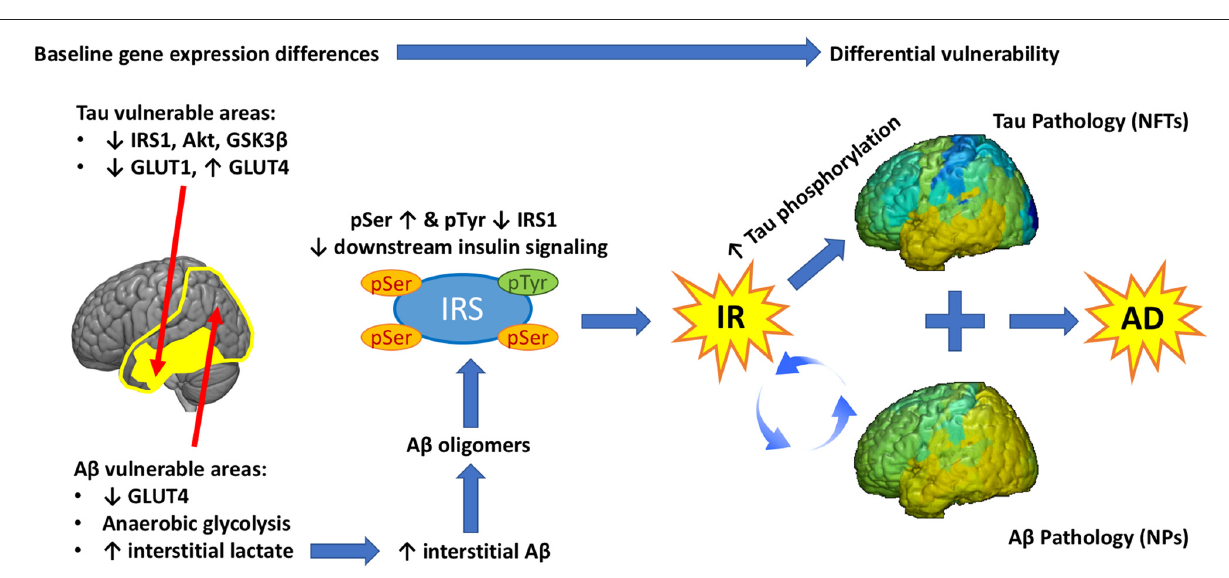
FIGURE 4 | Graphical abstract. Baseline differences in the expression of glucose transporters (GLUT) and insulin signaling genes determine the vulnerability of different brain regions to Tau and/or A β pathology. Extensive temporo-parietal areas of the brain show significant metabolic reliance on glycolysis, which generates lactate. High lactate is associated with high interstitial A β , which assembles into A β oligomers. These A β oligomers promote Ser phosphorylation of IRS-1, impeding downstream insulin signaling and leading to brain IR. A feed-forward loop is established between IR and A β pathology leading to progressive A β deposition in NP. Chronic IR promotes tau hyperphosphorylation and this effect is more pronounced in regions that show low expression of insulin signaling proteins (IRS-1, Akt, etc.) at baseline. As a result, hyperphosphorylated tau leads to the development of NFT in a different and more restricted regional pattern than A β . The sum of these three inter related pathologies (IR, A β , Tau) produces Alzheimer’s